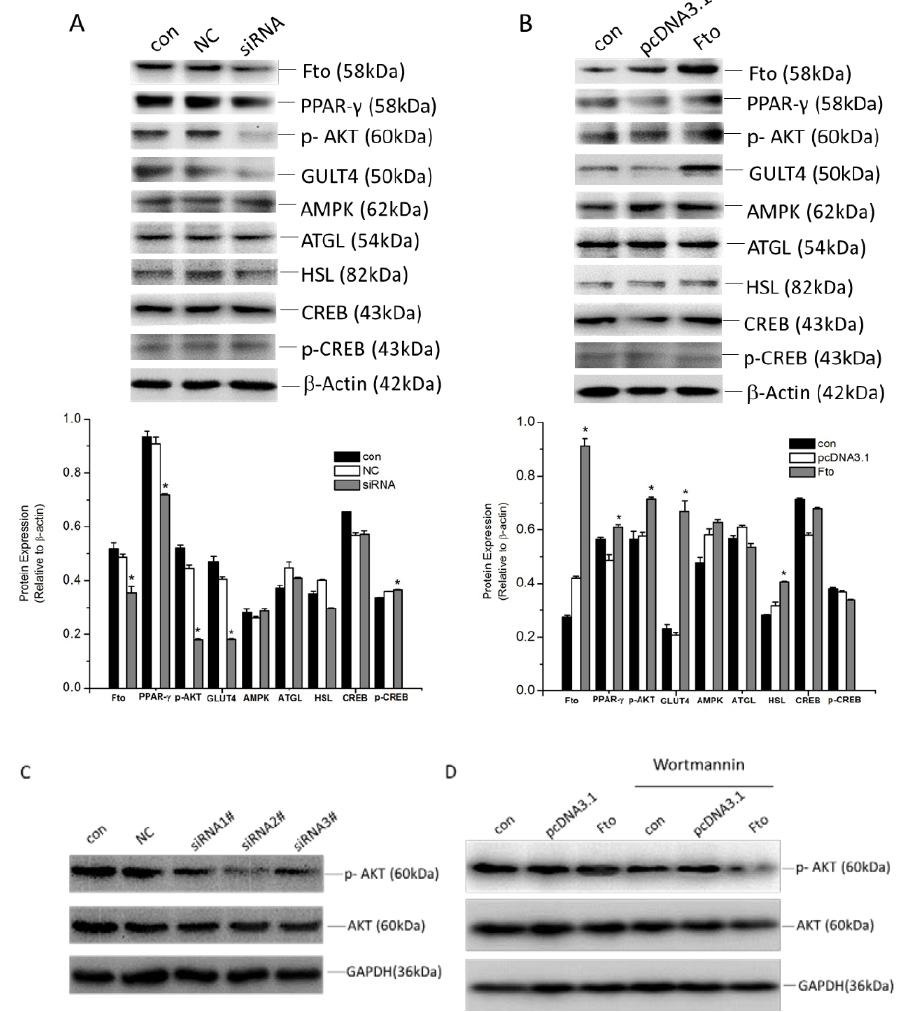
Figure 5. Effect of Fto on proliferation and differentiation of pre-adipocyte. ( A ) 3T3-L1 cells transfected with/without NC siRNA or Fto siRNA, as well as ( B ) Fto recombinant plasmid or vector “mock” transfected 3T3-L1 cells were harvested 24 h after transfection for protein extraction and quantified. Fifty microgram of total protein were analyzed by Western blot. Expressions and activities of specific transcription factors and signaling factors were detected. The expression level was displayed as fold changes in band density. Results are expressed as the means ± SD from three independent experiments. * p < 0.05, vs . the mock transfection group. ( C ) Further, three different Fto siRNA were transfected into 3T3-L1 cells for 24 h. The phosphor-Akt and Akt expression were examined by Western blot assay. ( D ) 3T3-L1 cells were transfected with vector plasmid and Fto plasmid for 24 h, then were cultured in the absence or presence of the PI3k inhibitor (Wortmannin, 100 nmol/L) for 24 h. The expression level of phospho-Akt and Akt was determined by Western blot analysis.